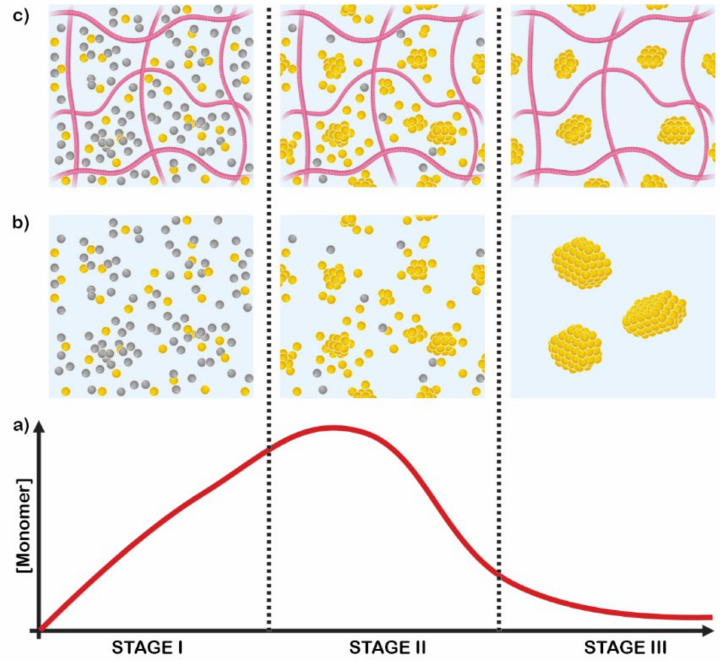
Figure 1. Gold nanoparticle growth according to LaMer’s mechanism ( a ), in absence ( b ) and in presence of polymer chains ( c